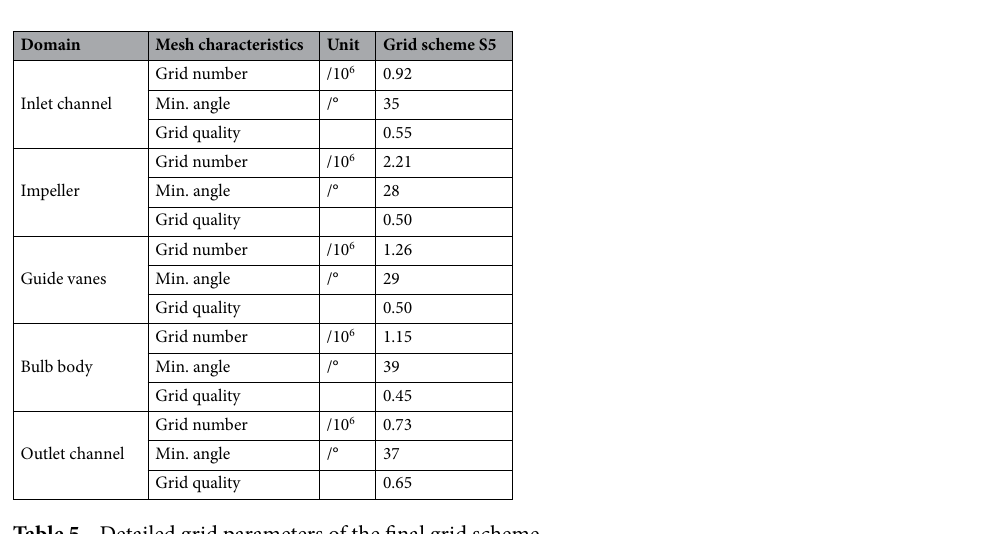
Table 5. Detailed grid parameters of the final grid